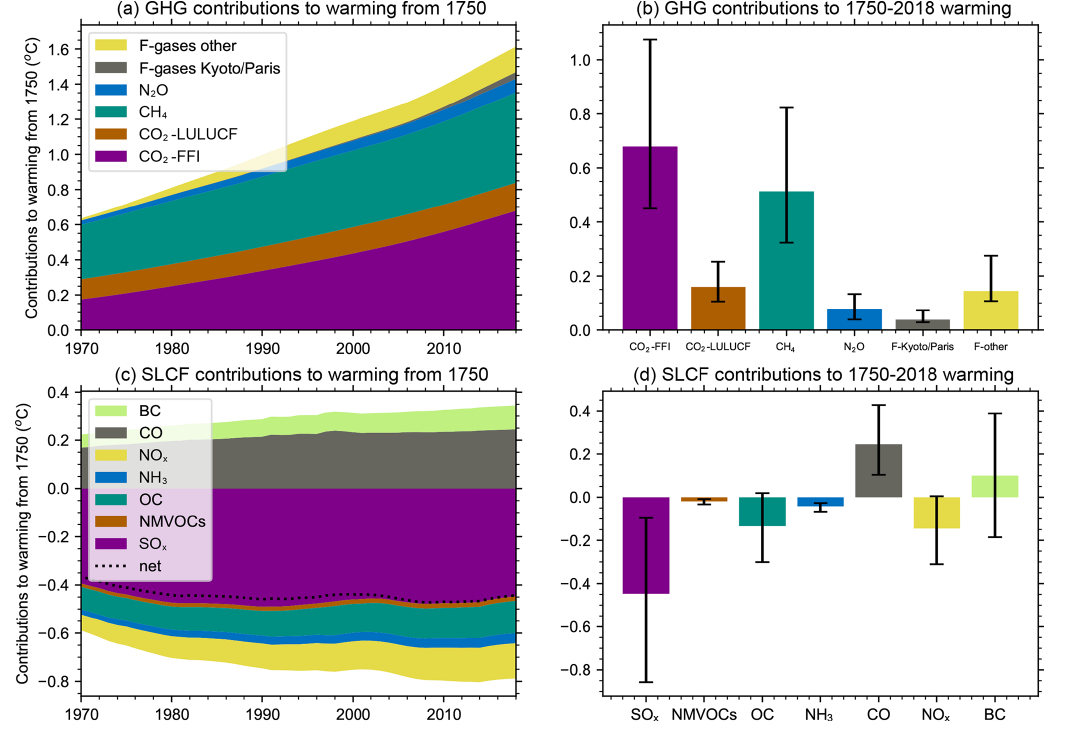
Figure 4. Contribution of different GHGs to global warming over the period 1750 to 2018. (a, b) Contributions from estimated with the FaIR reduced-complexity climate model. Major GHGs and aggregates of minor gases as a time series in (a) and as a total warming bar chart with 90% confidence interval added in (b) . (c, d) Contribution from short-lived climate forcers as a time series in (c) and as a total warming bar chart with the 90% confidence interval added in (d) . The dotted line in (c) gives the net temperature change from short-lived climate forcers. F-Kyoto/Paris includes the gases covered by the Kyoto Protocol and Paris Agreement as well as the HFCs, while F-other includes the gases covered by the Montreal Protocol but excluding the HFCs. Table 7. Average annual anthropogenic GHG emissions by decade and for selected individual years 1970–2018: CO 2 from fossil fuel combustion and industrial processes (FFI); CO 2 from land use, land-use change, and forestry (LULUCF); CH 4 ; N 2 O; fluorinated gases (F-gases: HFCs, PFCs, SF 6 , NF 3 ). Aggregate GHG emissions trends by groups of gases reported in GtCO 2 eq . converted based on global warming potentials with a 100-year time horizon (GWP-100) from IPCC AR6 (Forster et al., 2021). Uncertainties are reported for a 90% confidence interval (see Sect. 3). Levels and growth are average values over the indicated time period. Additional Supplement tables show similar average annual GHG emissions by decade, also for major sectors (Table S2) and regions (Table